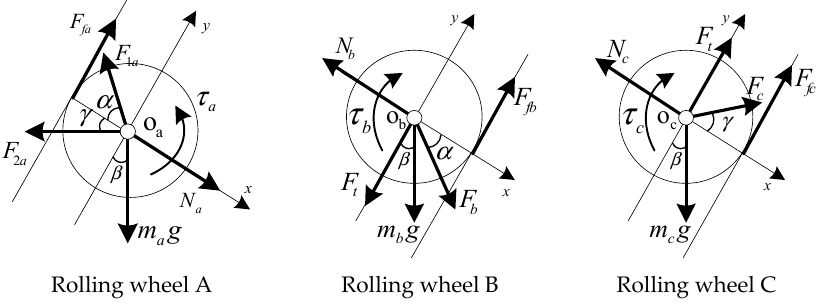
Figure 7. Force balance relationships of rolling wheels.